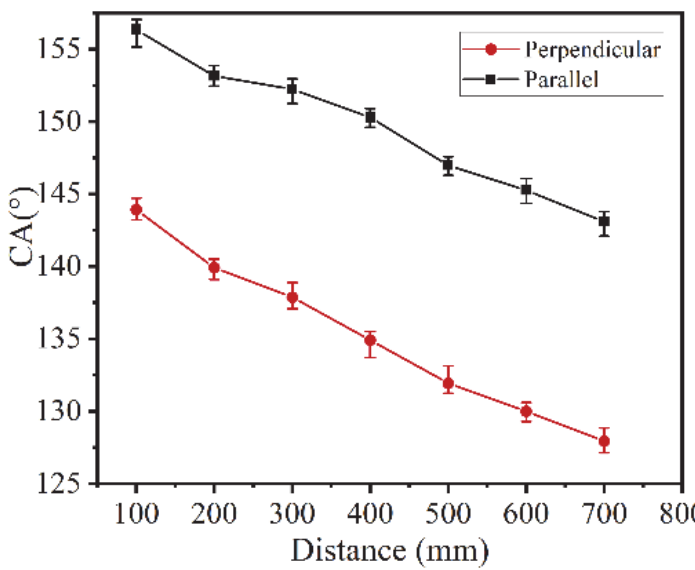
Figure 9. CA with different friction distances.